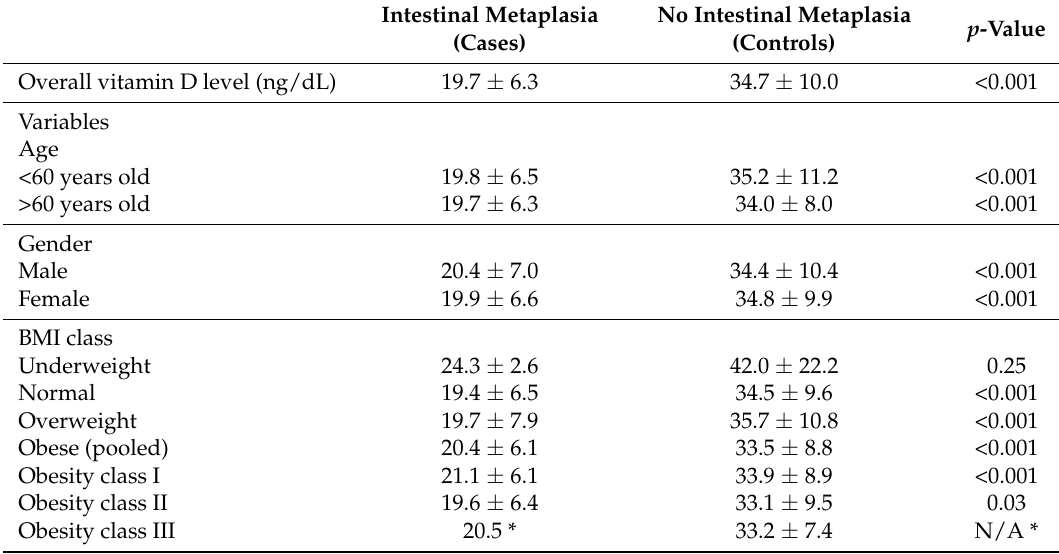
Table 3. Average vitamin D levels among subjects with and without gastric incomplete intestinal